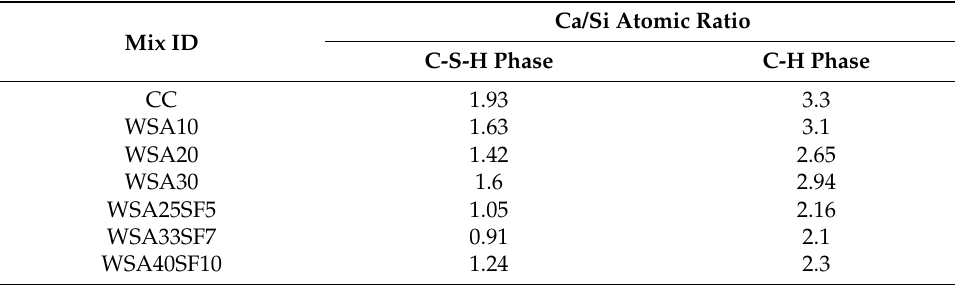
Figure 6. SEM–EDS spectrum of control, binary (C/WSA), and ternary (C/WSA/SF) paste samples ( a , b ) control, ( c , d ) WSA10, ( e , f ) WSA20, ( g , h ) WSA30, ( i , j ) WSA25SF5, ( k , l ) WSA33SF7, ( m , n ) WSA40SF10. Table 6. Ca/Si atomic ratio from EDS analysis of control and mixes containing different percentages of WSA alone and WSA with SF.